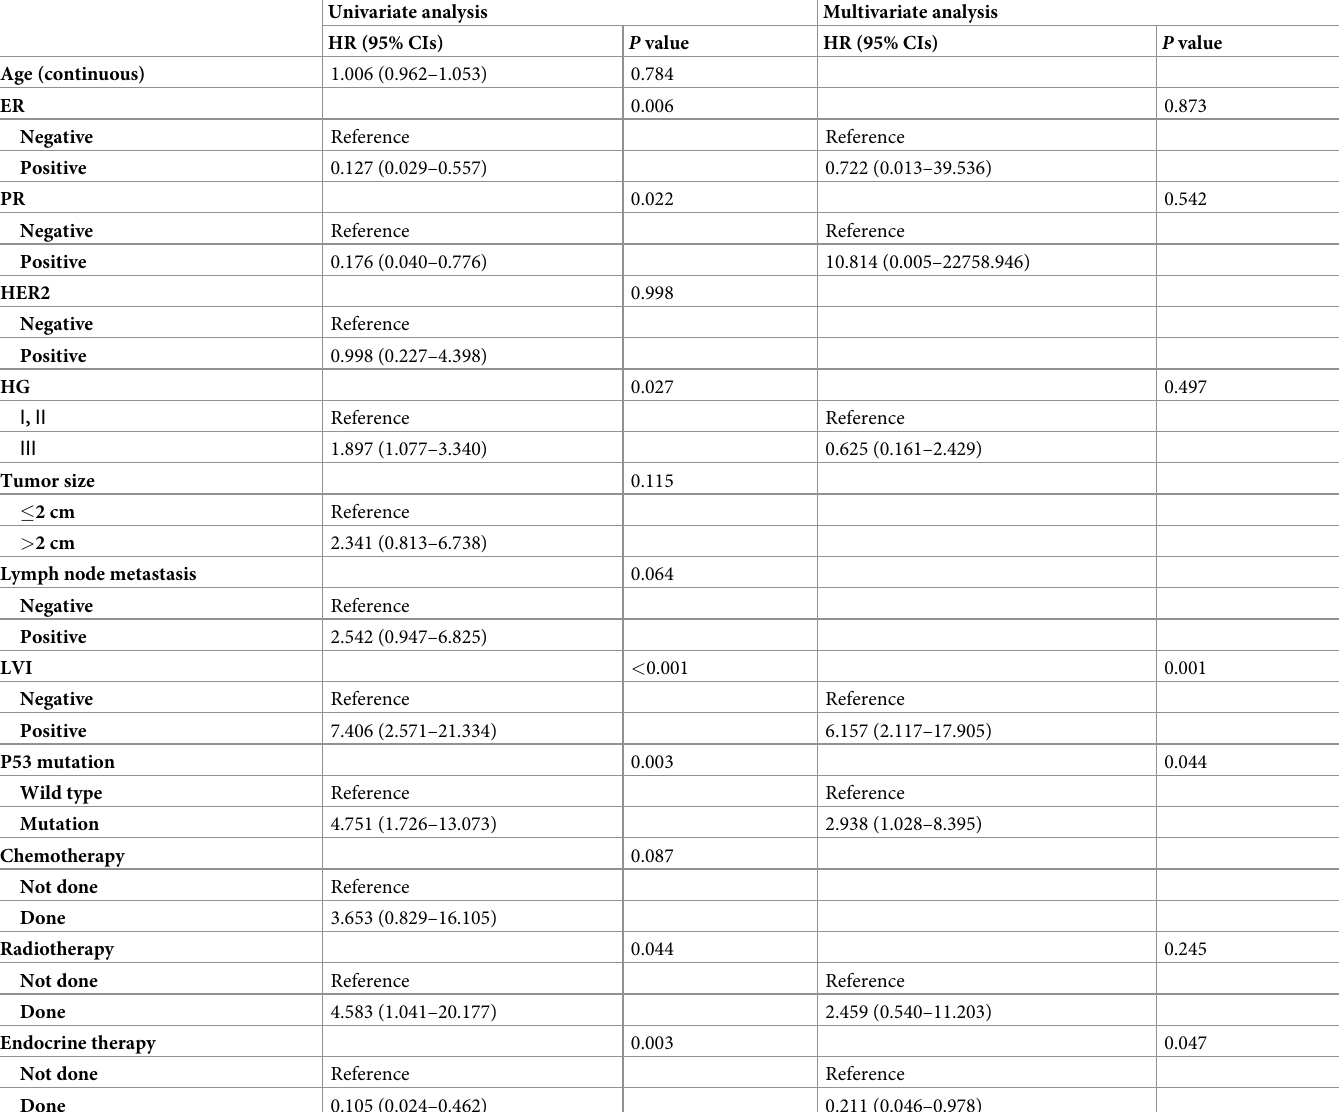
Table 2. Uni- and multivariate analysis for overall survival in patients with low nuclear YAP1 expression